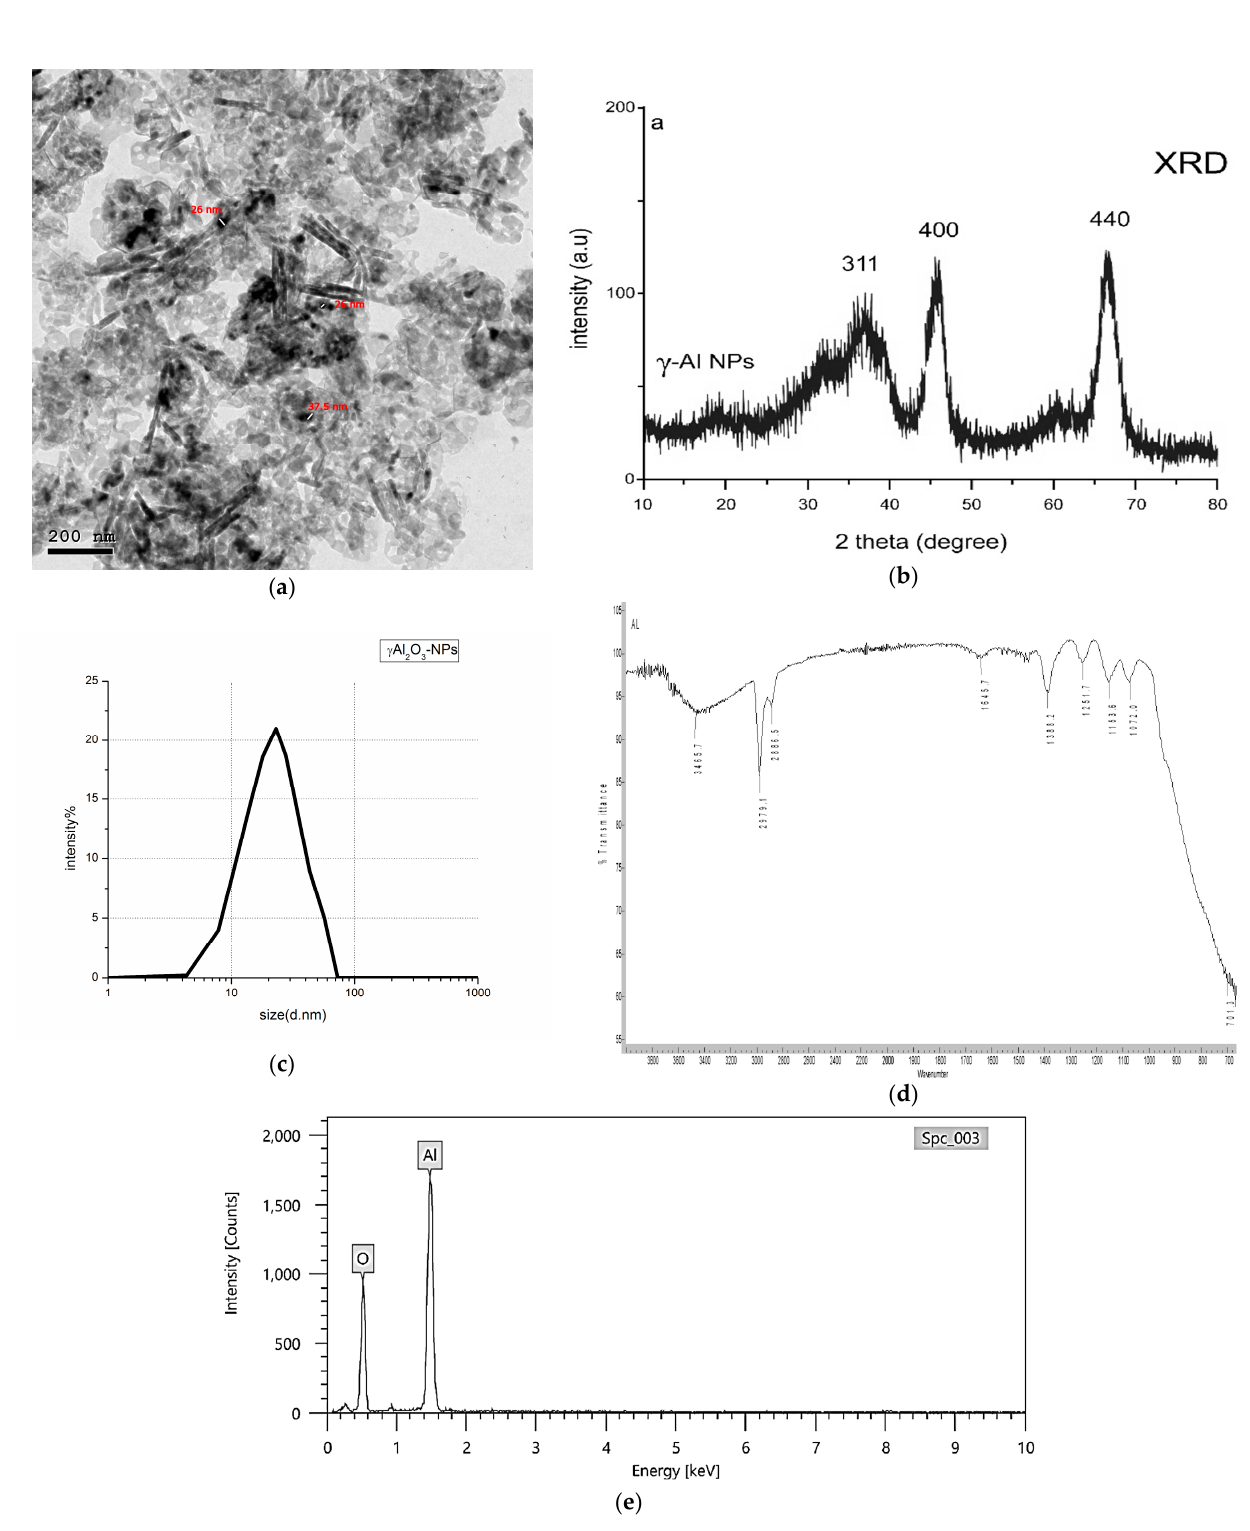
Figure 1. Physicochemical characterization of the synthesized γ -Al 2 O 3 , including ( a ) TEM, ( b ) XRD pattern, ( c ) particle size, ( d ) FTIR spectroscopy, and ( e ) EDX studies of the synthesized nanoparti-